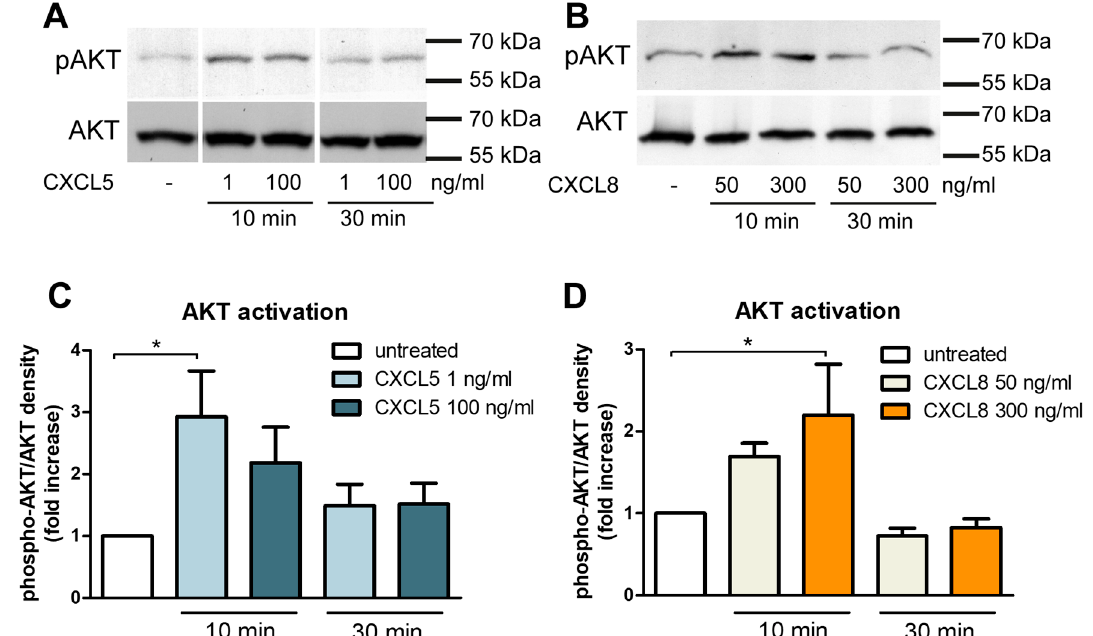
Figure 5. CXCL5 and CXCL8 rapidly and transiently activate Akt/PKB in human brain endothelial cells. Representative Western blot analysis of hCMEC/D3 whole cell protein extracts after stimulation with 1 or 100 ng/mL CXCL5 ( A ) and 50 or 300 ng/mL CXCL8 ( B ) for 10 or 30 min, staining against phosphorylated and total Akt. Quantification of Akt activation upon CXCL5 ( C ) and CXCL8 ( D )